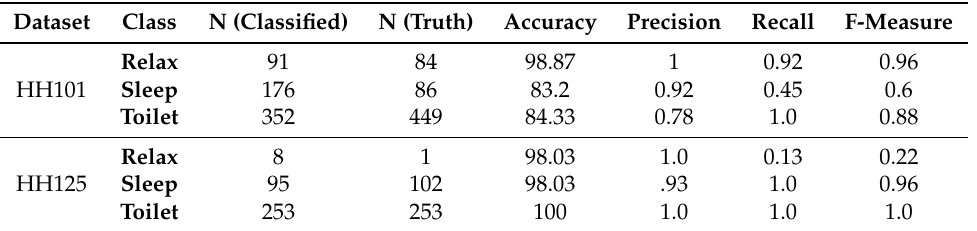
Table 7. Performance metrics for zero-shot activity recognition—Scenario 1.